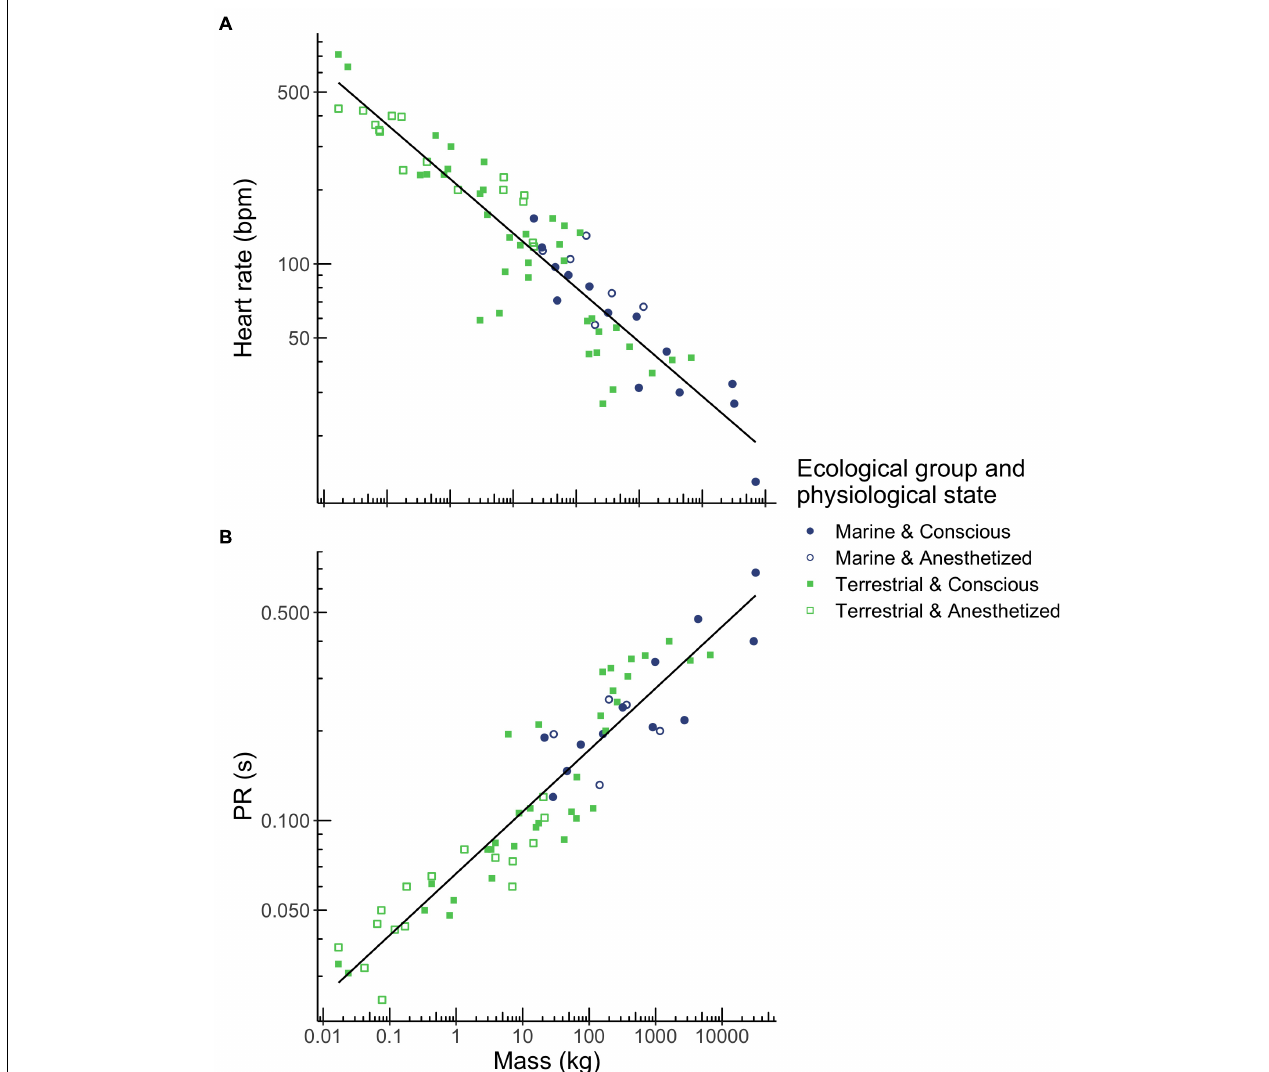
FIGURE 1 | Relationships between body mass and heart rate (A) , and PR interval duration (B) in mammals. Mass was the best predictor for these three ECG parameters. Ecological group (terrestrial mammals shown in green squares, marine mammals shown in blue circles) and physiological state (conscious mammals indicated by closed squares and circles, anesthetized mammals indicated by open squares and circles) had no effect on heart rate or PR interval. Regression equations for each parameter are provided in Table 2